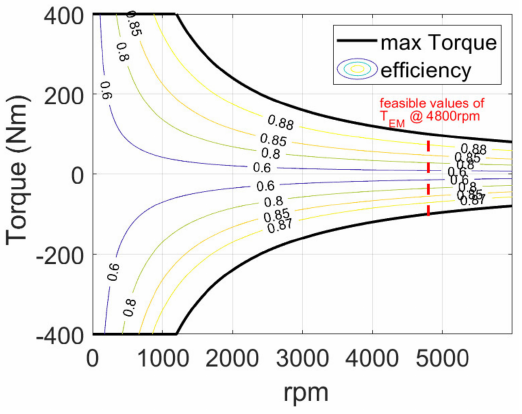
Figure 9. Efficiency map of EM 2 and Range of possible torque values @4800 rpm.